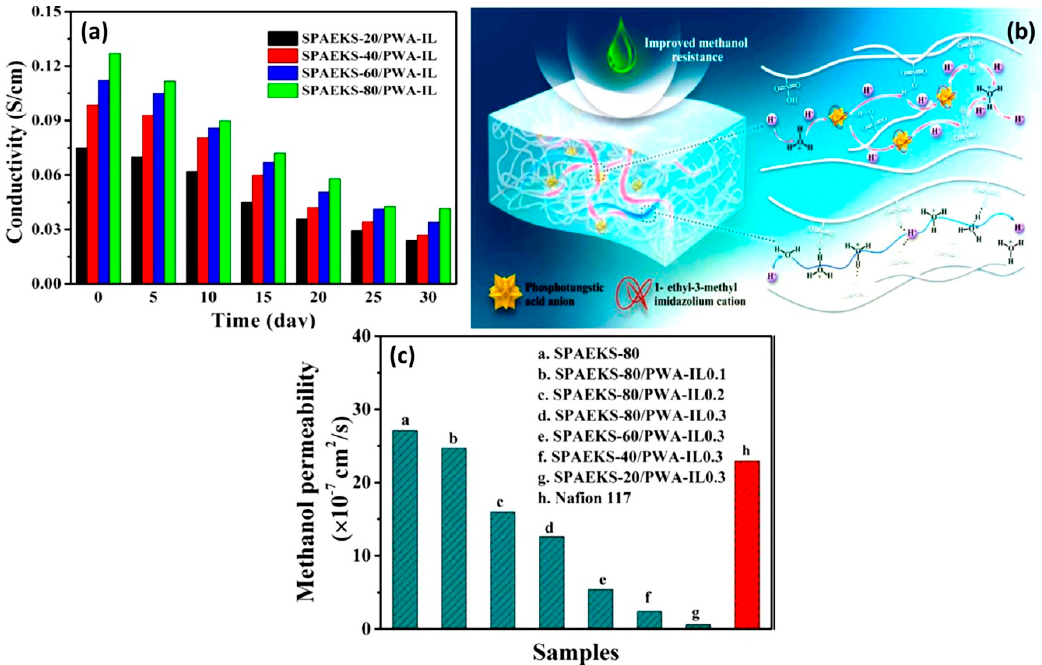
Figure 15. ( a ). The conductivity of SPAEKS ‐ X/PWA ‐ IL membranes at 80 °C during 30 days ( b ). Illustration of two proton transport mechanisms in SPAEKS ‐ X/PWA ‐ IL membranes. ( c ) Methanol permeability of composite membranes and Nafion ® 117 at room temperature. Reproduced with permission from [106]. Copyright Elsevier, 2017.